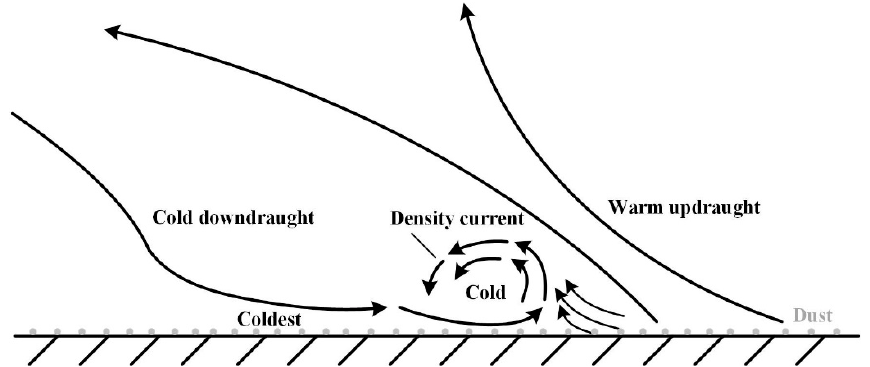
Figure 3. Schematic diagram of the front lobe of a dust storm. A downdraught of the cold air that spreads out along the ground and moves forward to form a density current pick up loose dust and sand from the surface. The dense cold air pushes up warmer air, which it meets, thereby reinforcing the warm up-draught (Modified from Idso, S.B. 1976, pp. 108–114).